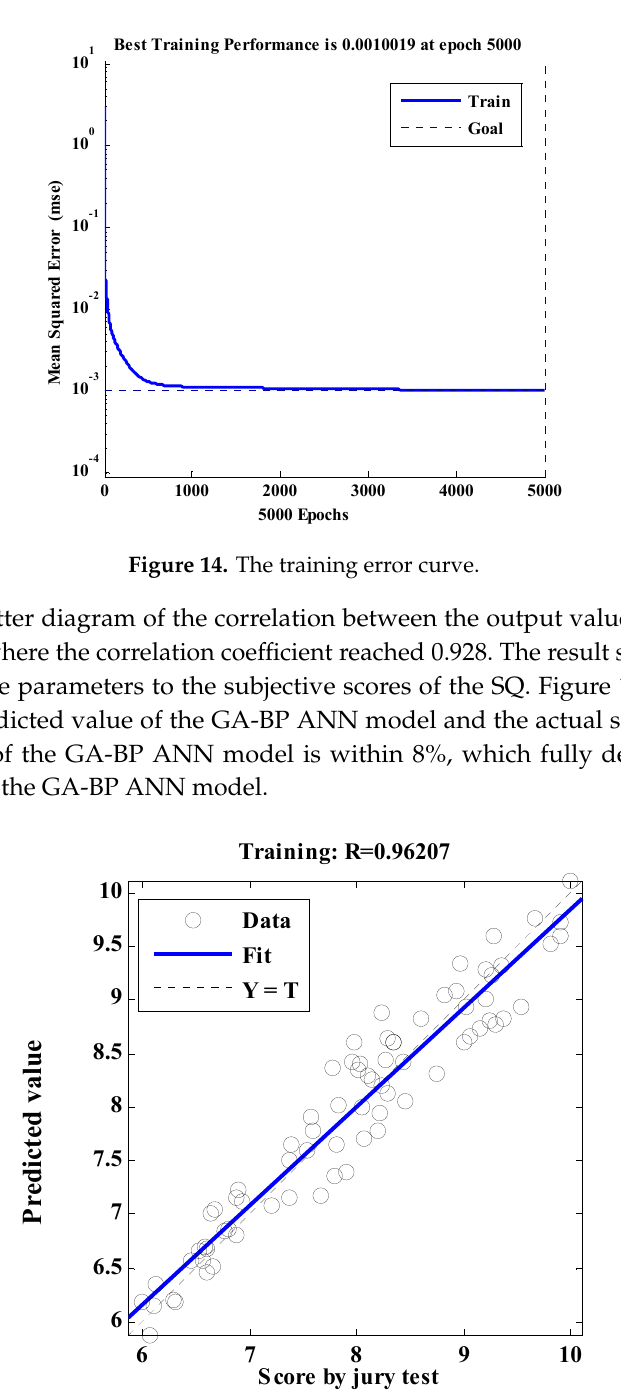
Figure 15. Correlation between the prediction value of the model and the scores of the jury test.